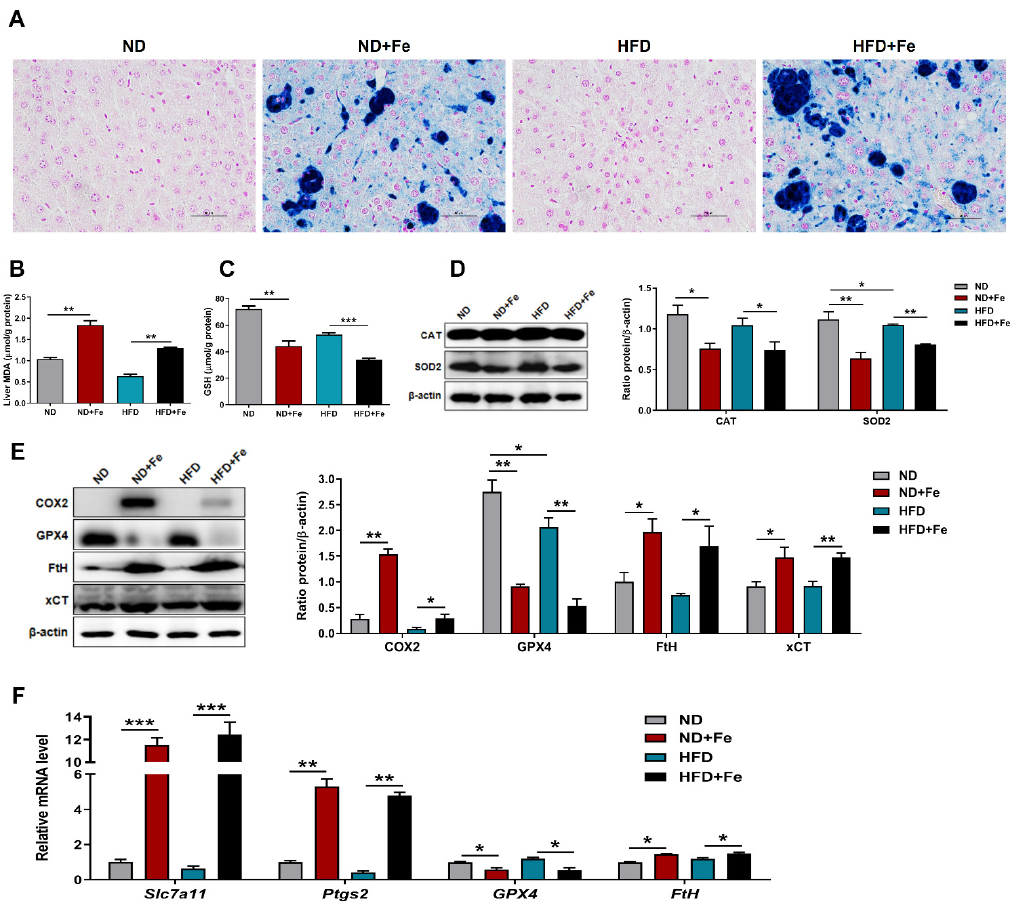
Figure 6. Induced ferroptosis in the liver of iron overload mice. ( A ) Representative images of liver sections stained with Perl’s blue; ( B ) Hepatic MDA content; ( C ) Hepatic GSH content; ( D ) Western blot analysis of CAT, SOD2 protein expression and their quantification in liver samples; ( E ) Western blot analysis of ferroptosis related protein (COX2, GPX4, FtH, xCT) expression and their quantification in liver samples; ( F ) Relative expression levels of genes related to ferroptosis (Slc7a11, Ptgs2, GPX4, FtH) in liver. ND ( n = 6), ND + Fe ( n = 7), HFD ( n = 7), and HFD + Fe ( n = 8). The values are the means ± SEMs. * p < 0.05, ** p < 0.01, *** p < 0.001. Significant differences between two group were analyzed with the two-tailed Student’s t test.